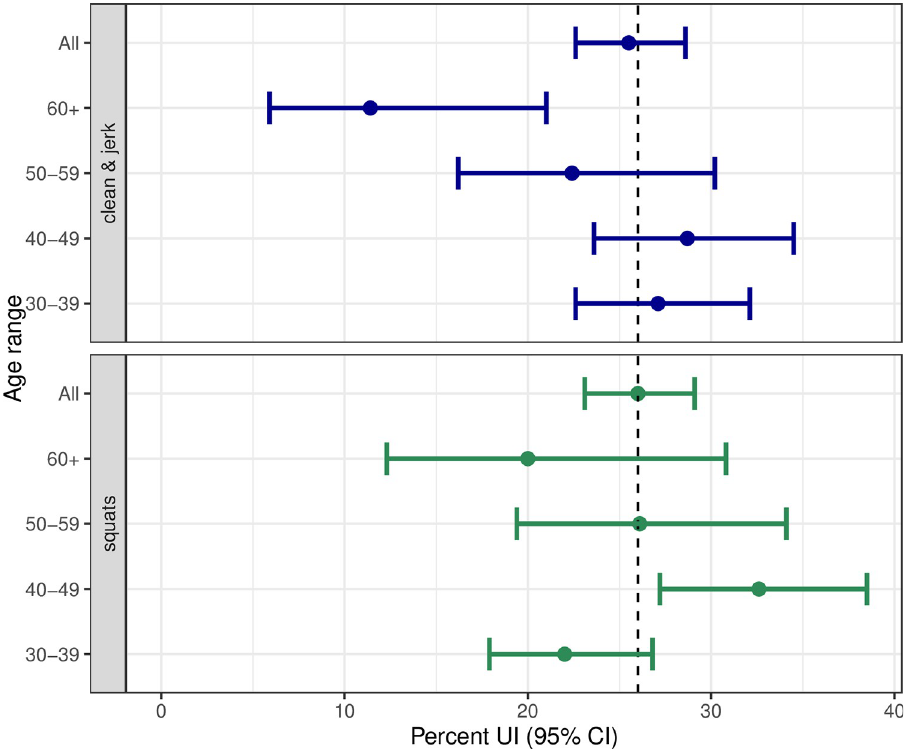
Fig 1. Prevalence of UI in clean & jerk and